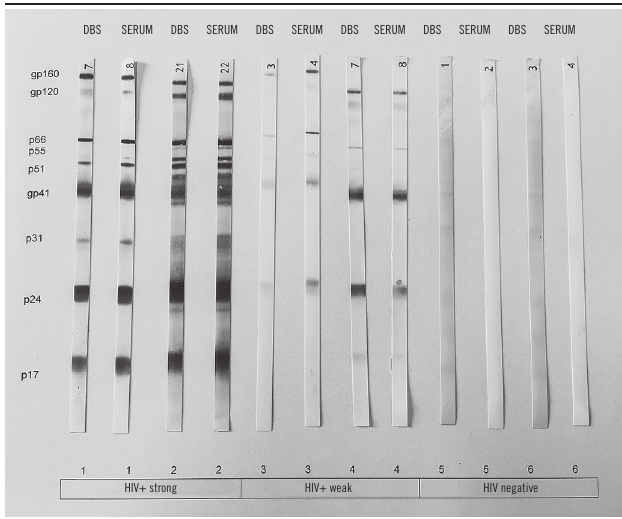
figurE 1 − Evaluation of accuracy in six paired DBS and plasma samples DBS: dried blood spot; +: positive.